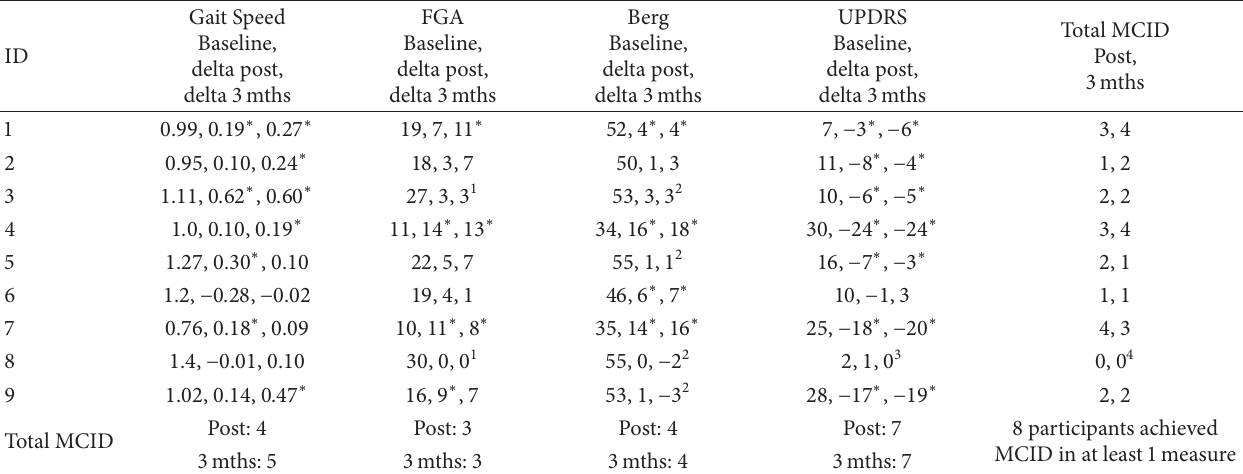
Table 4: Primary outcomes and MCID.